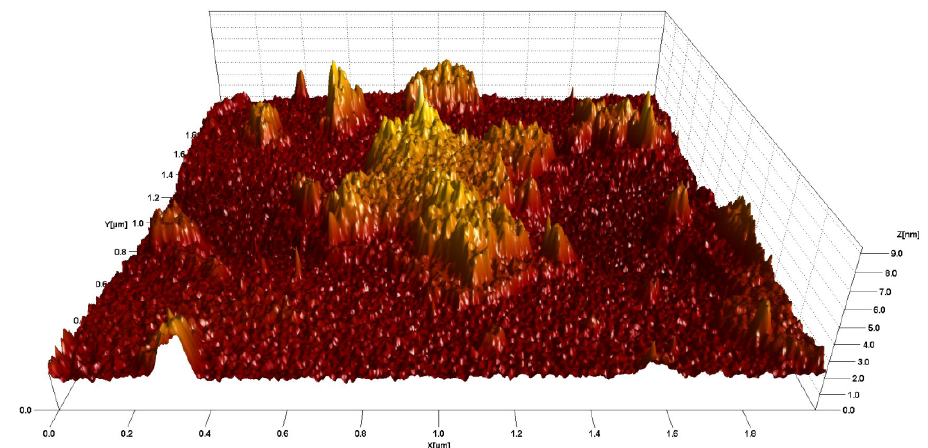
Figure 5. AFM images of GO-DOPO-V in the 3D view.